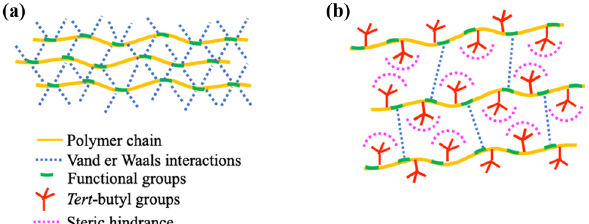
Figure 12: General cartoon representation on the e ff ect of the bulky groups ( tert - butyl ) on the polymer chain packing and FFV. ( a ) Compact polymer chain packing in case of polymer without bulky groups. ( b ) Disruptive polymer packing and higher free space for the polymers having the bulky